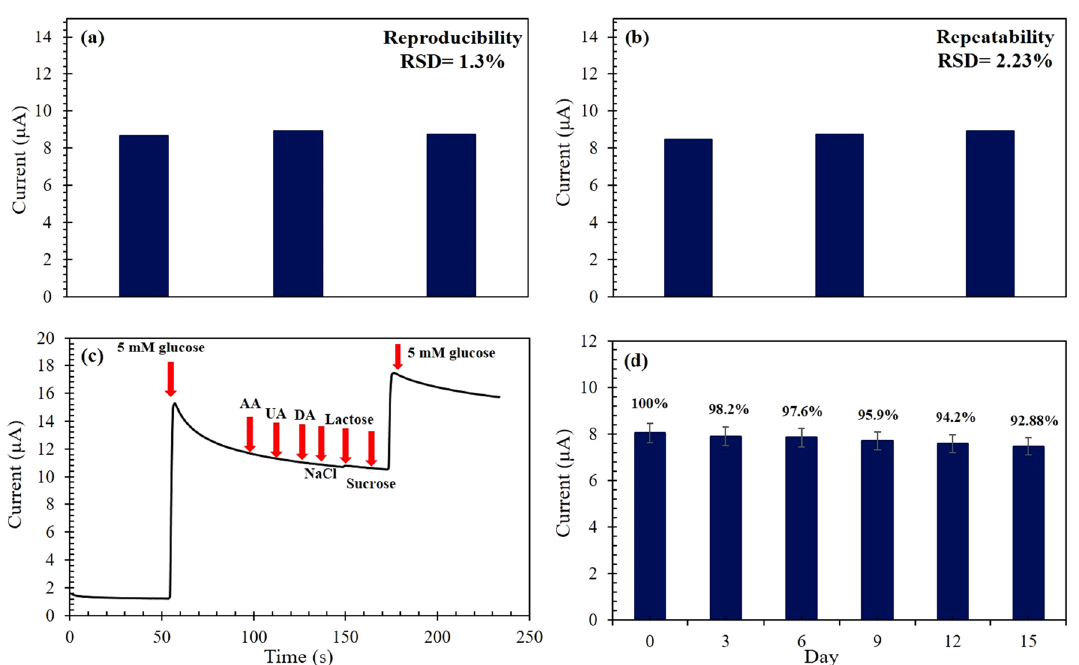
Figure 9. ( a ) Reproducibility, ( b ) repeatability, ( c ) selectivity, and ( d ) stability of Nafion/CuO/ZnO- DSDSHNM/GCE response for 5 mM of